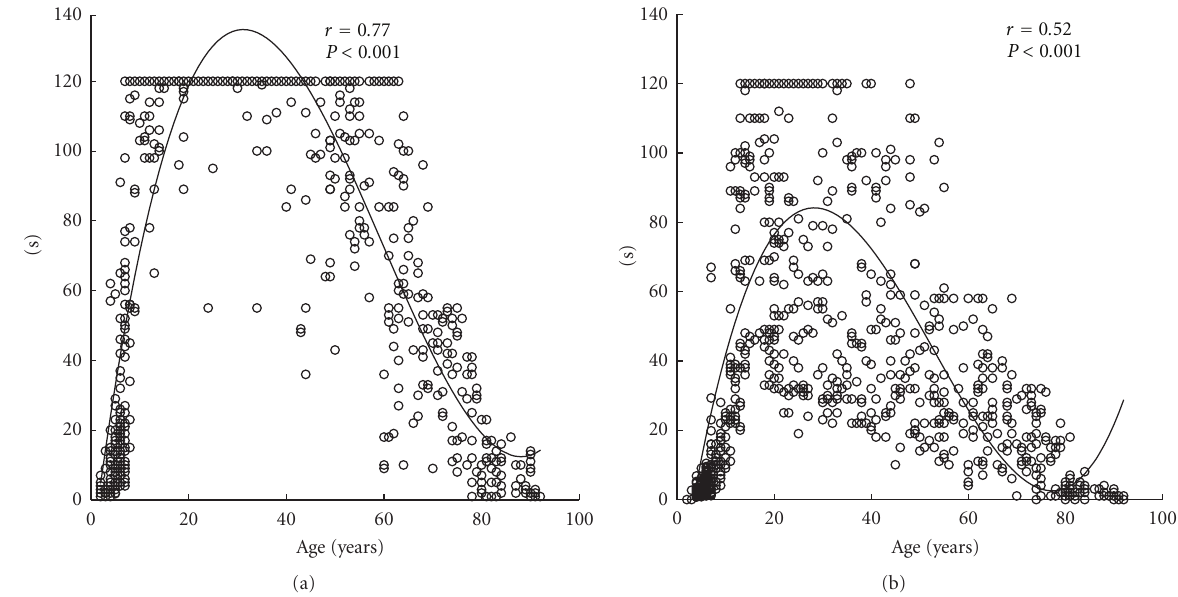
Figure 2: The standing time on one leg versus age for the eyes open (a) and eyes closed (b) along with the respective cubic regression lines. All data is shown ( n = 1241). Ages at the maximum values in cubic curves were 31.2 years for open eyes and 28.2 years for closed eyes, and ages at the minimum values were 88.1 years for open eyes and 77.3 years for closed